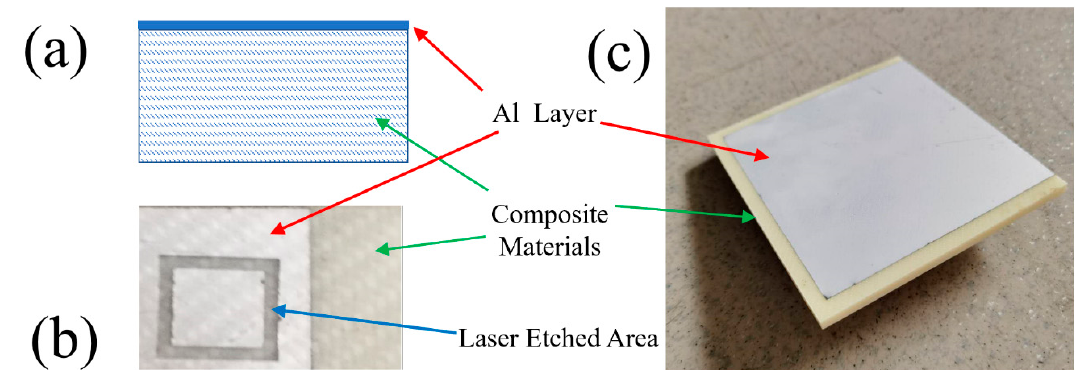
Figure 1. A cross-section schematic of the studied composite sheet ( a ), a top view of the sample ( b ) and the raw sample sheet ( c ). The thicknesses for the Al layer and the composite materials were 20 µ m and 4.2 mm, respectively.